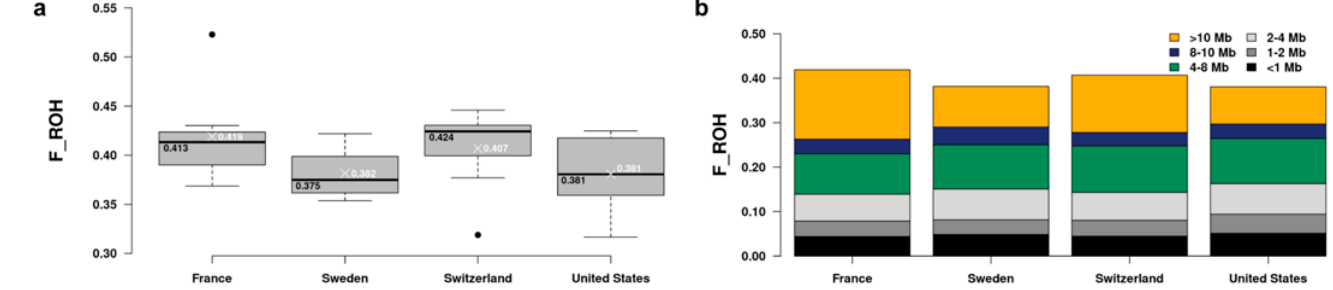
Figure 2. Comparison of the genomic inbreeding coefficients (F_ROH) between Bernese mountain dogs from the four countries. ( a ) Box plots of the F_ROH distribution in the European countries and the United States showing the median (black lines) and mean (white crosses) values in each group. ( b ) Average F_ROH per country; different colors represent contribution of the ROH length classes.